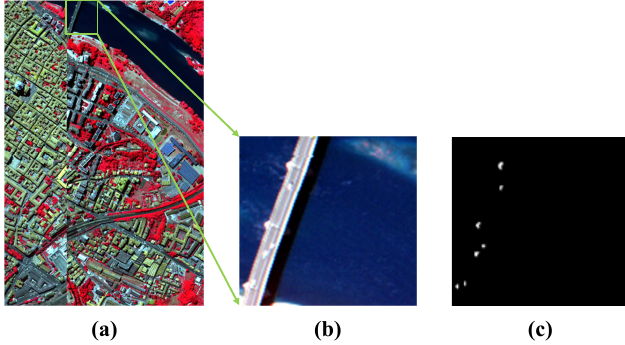
Figure 7. Pavia Center (PaviaC) dataset. ( a ) Whole Pavia Center (PaviaC) dataset; ( b ) Smaller subset of the scene; ( c ) Ground truth for the anomaly